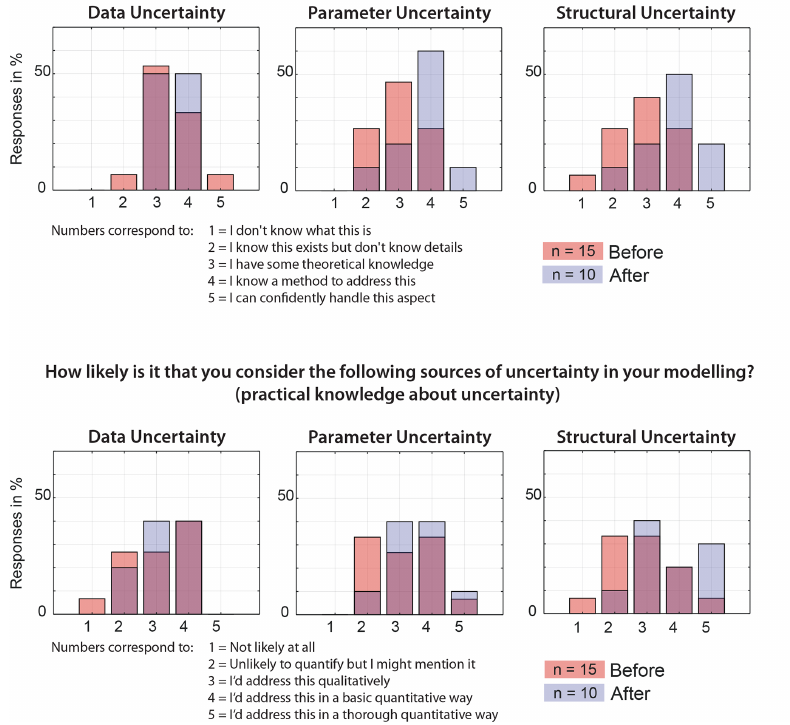
Figure 6. Comparison of responses to two questions evaluating student knowledge on different uncertainty aspects before and after the MARRMoT course. A value of 1 indicates no knowledge and 5 indicates knowledge about theoretical and practical aspects of different uncertainty